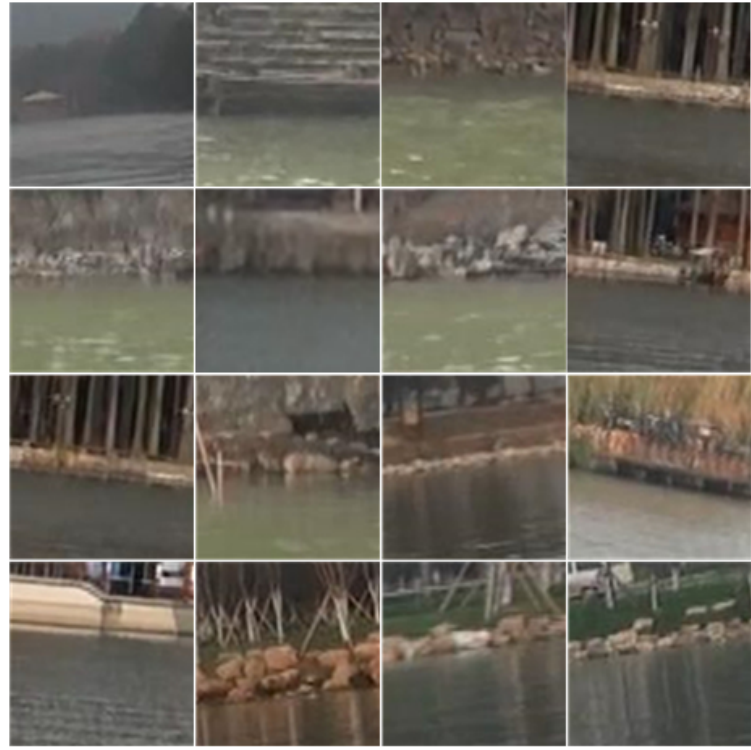
Figure 3. Sixteen original manual patches (here, r = 64 and s =